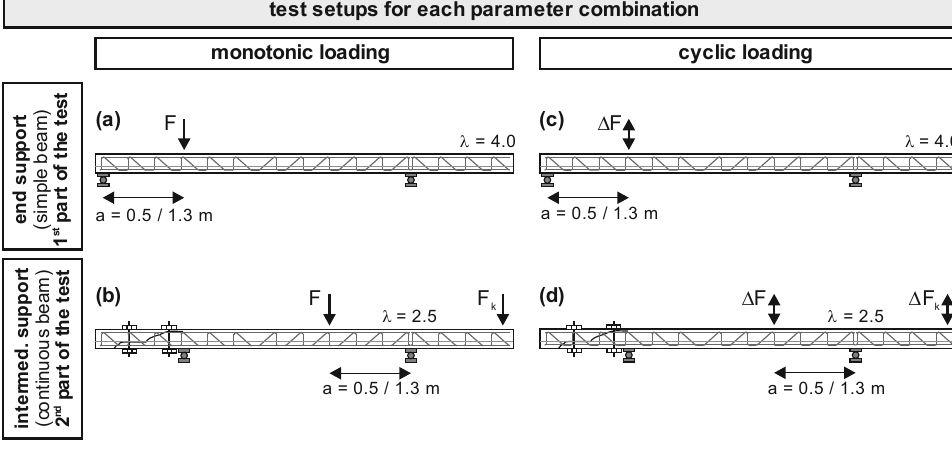
Figure 22. Test setups for each parameter combination in Series 3 and 4.